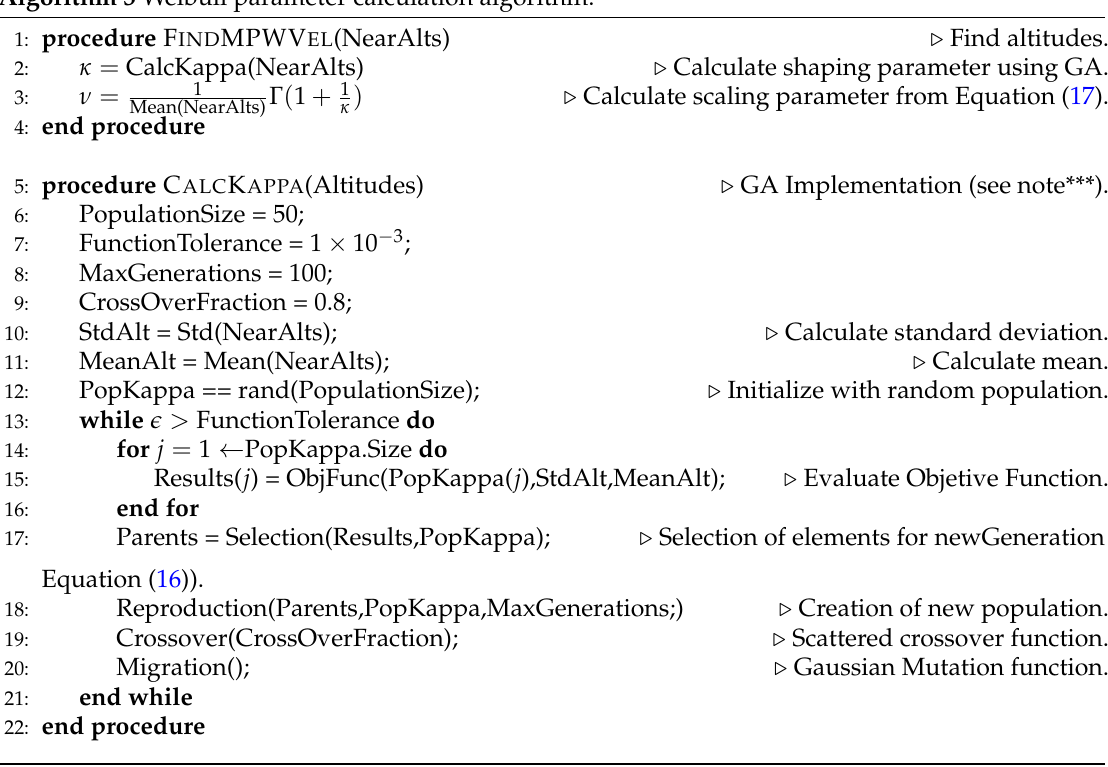
Algorithm 3 Weibull parameter calculation